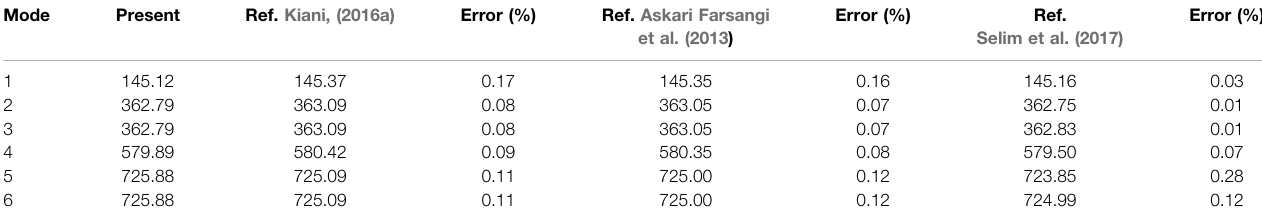
TABLE 2 | First six natural frequencies of the piezoelectric-integrated plate (SSSS). Mode